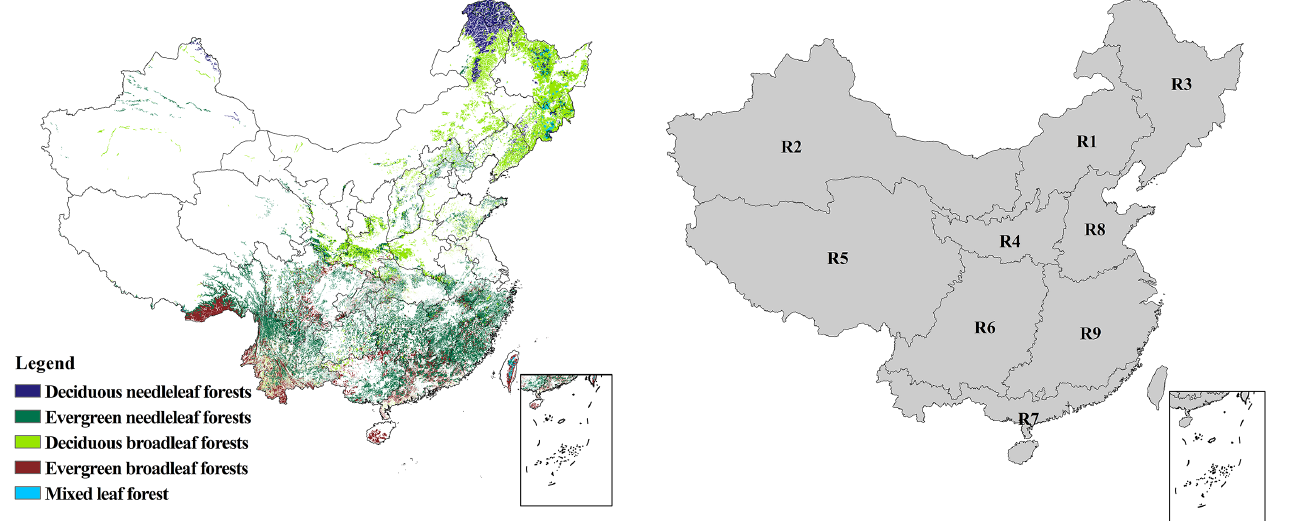
Figure 2. Map showing the nine regions of China used for detailed